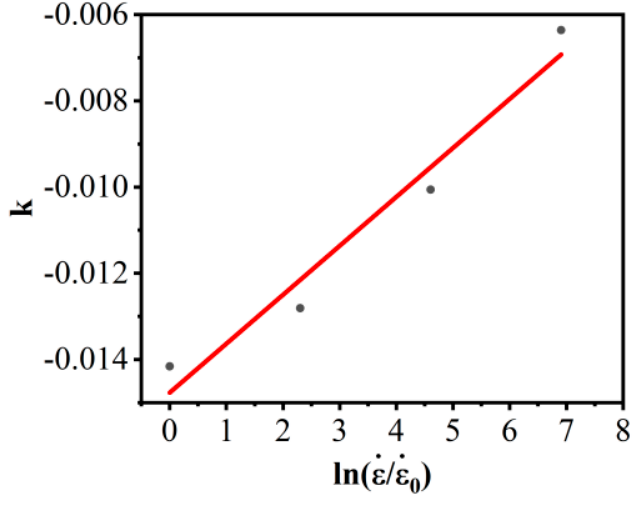
• • ε / ε 0 ) in M–JC. •• εε in M–JC.